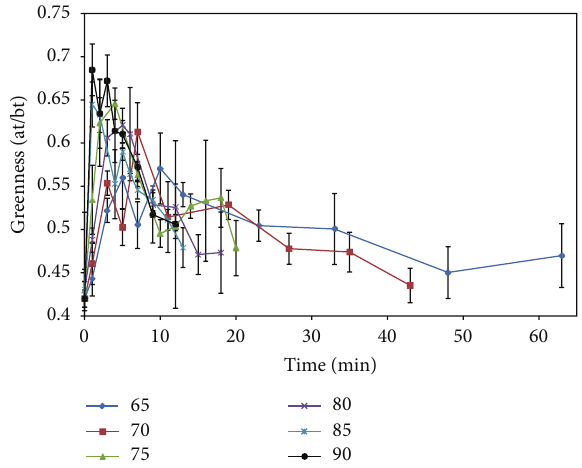
Figure 2: Greenness changes in whole spinach leaves (adapted from